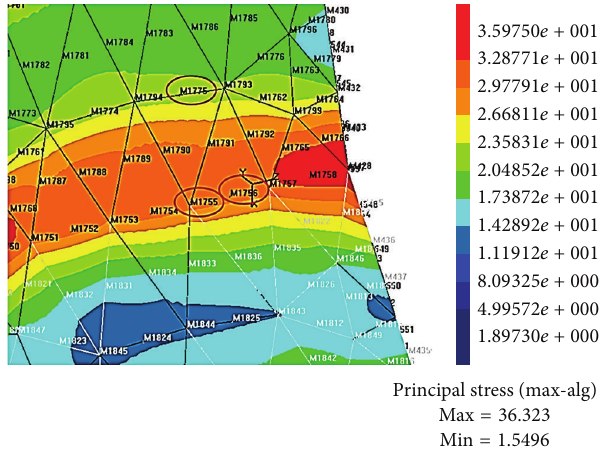
Figure 5: Simulation processes for the crack growth analysis.